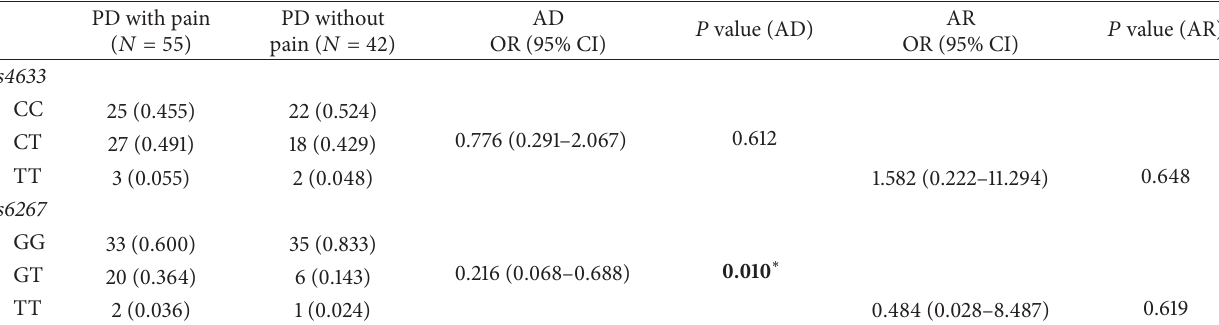
Table 1: COMT genotype and PD with or without pain.